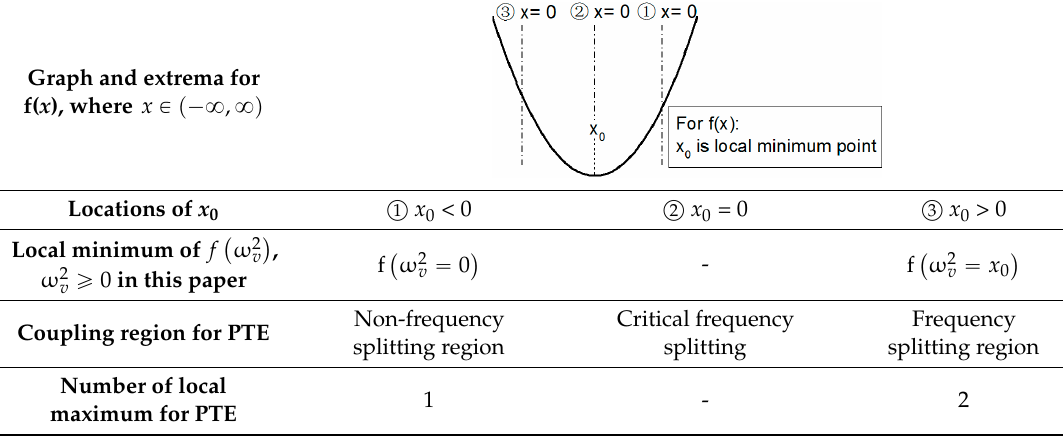
x   , the two splitting 0